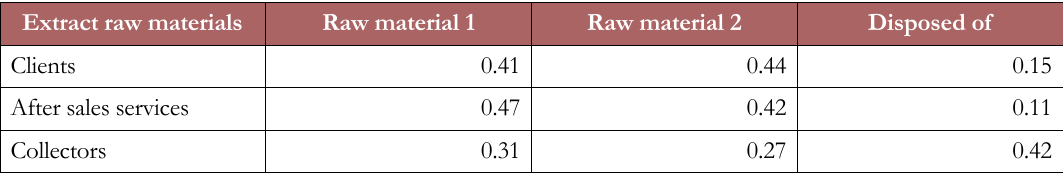
Table 4. Ratio of extracted material depending on the source of returns